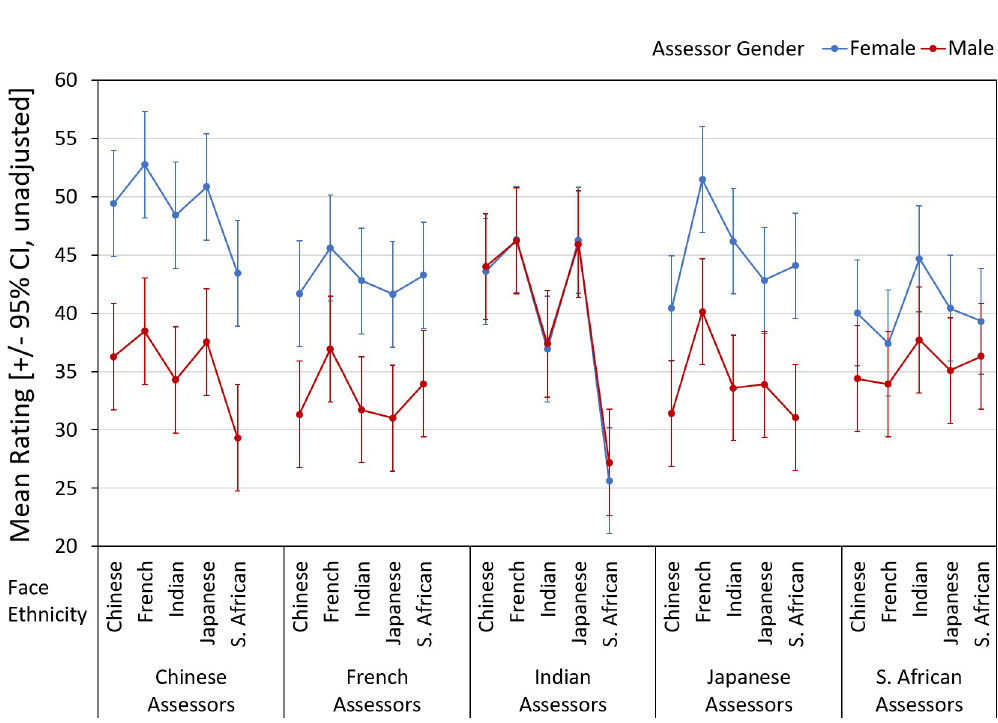
Fig 4. Assessments of facial images, by participant (“face”) ethnicity, assessor ethnicity and gender for attractiveness.